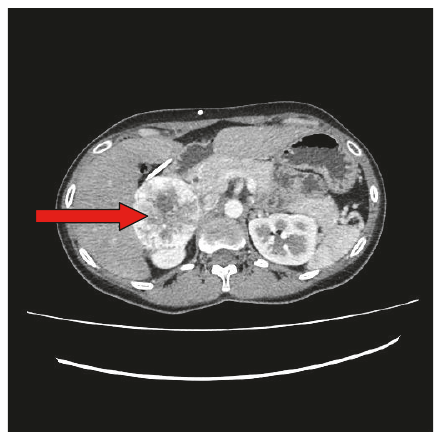
Figure 3: Well-defined avidly enhancing (190 HU) mass lesion 66 x 59 mm in the region of R/suprarenal gland. There is a centrally nonenhancing component suggestive of necrosis (red arrow). No evidence of